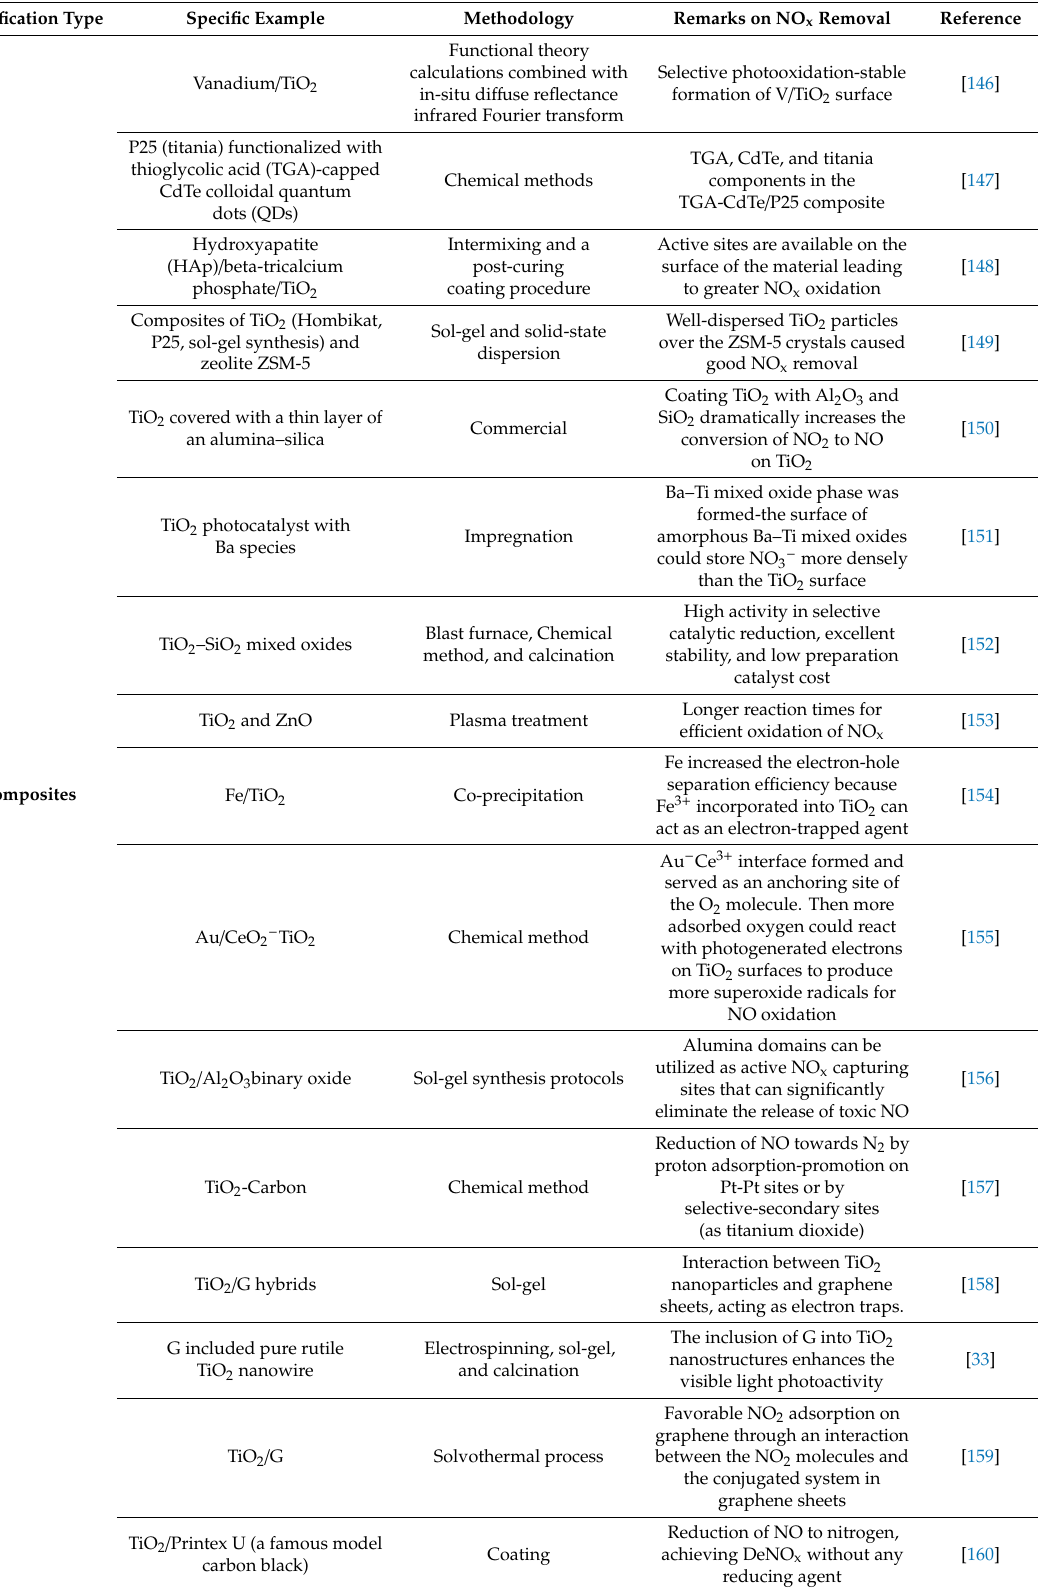
Table 2. Summary of TiO 2 based photocatalytic composites for NO x